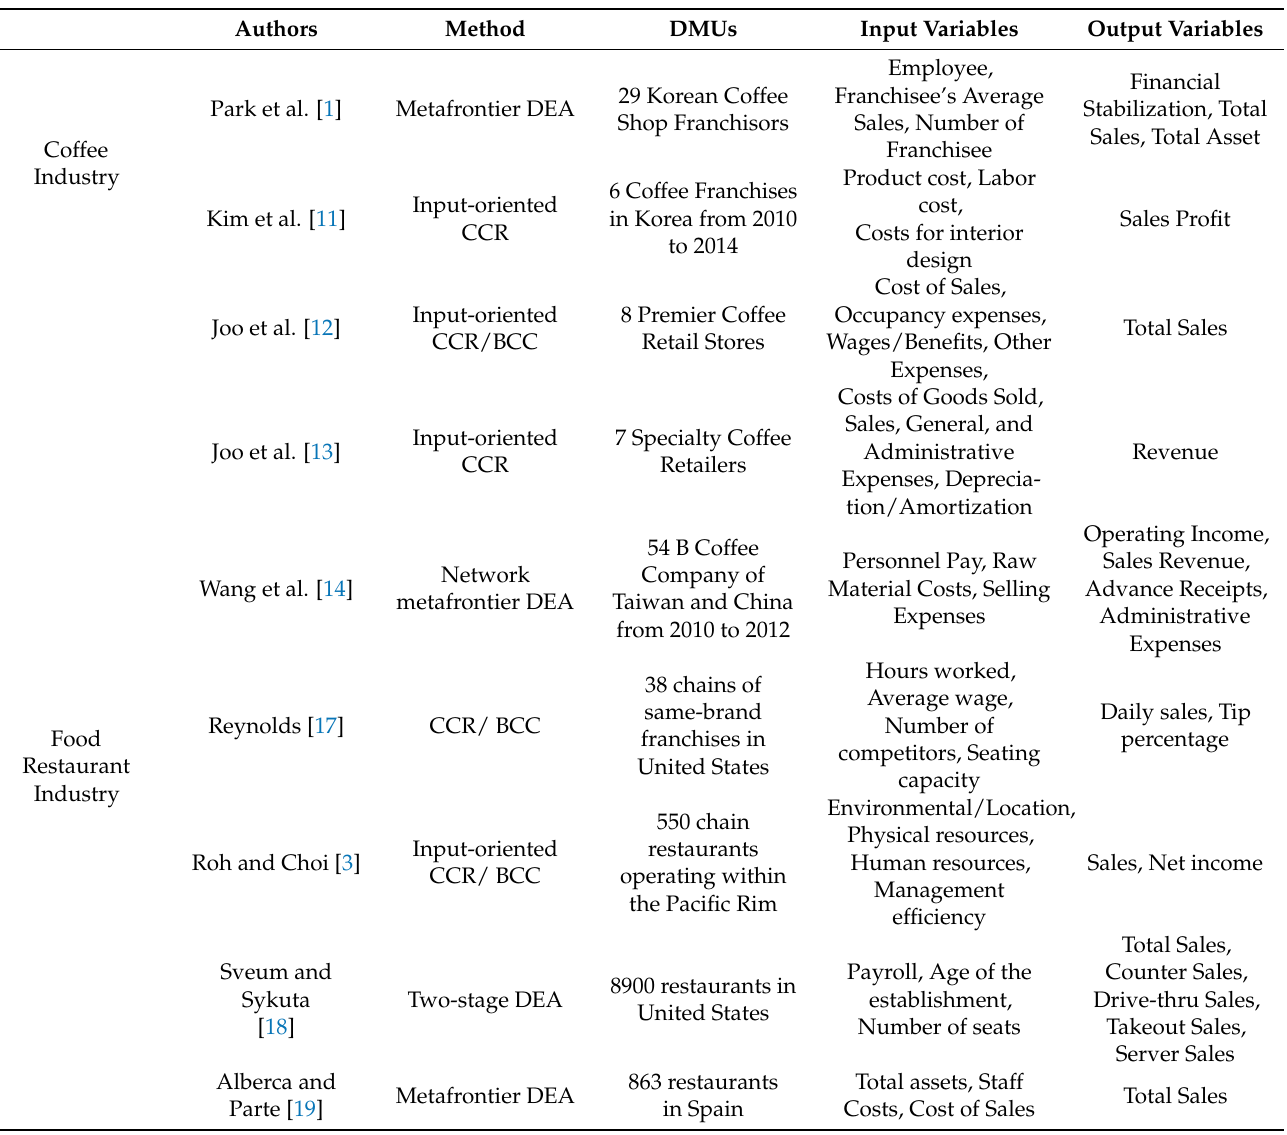
Table 1. Literature review of coffee franchise